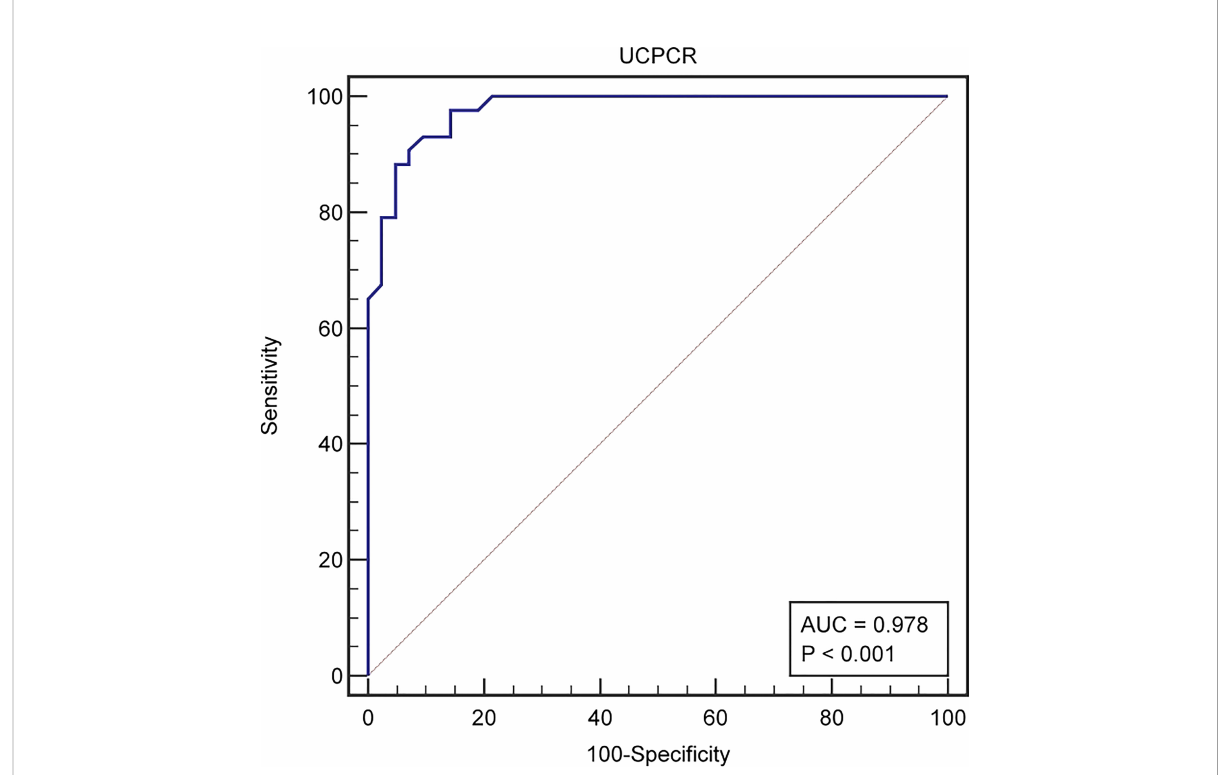
FIGURE 2 The ROC curve identi fi ed a cut-off UCPCR ≤ 1.13 nmol/g for discriminating poor islet function in T2DM patienets (AUC 0.978) with 88.37% sensitivity and 95.24% speci fi